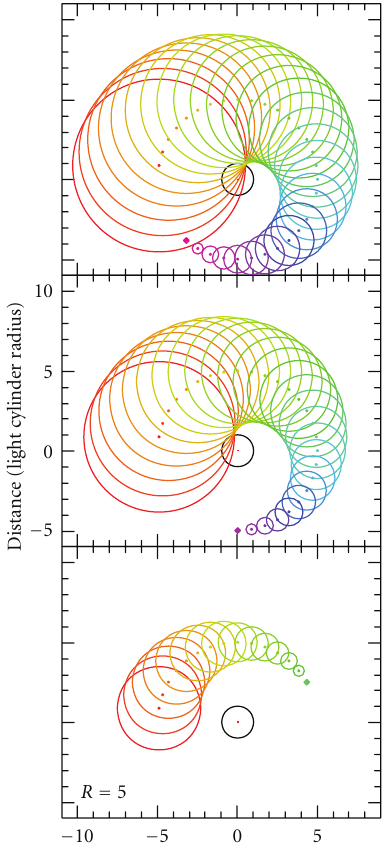
Figure 13: Bottom to top: a progression of Huygens’ wavelets for a supraluminal source moving at 5 times the speed of light, with 36 wavelets in a full circle. The light cylinder footprint is marked by the small black circle.